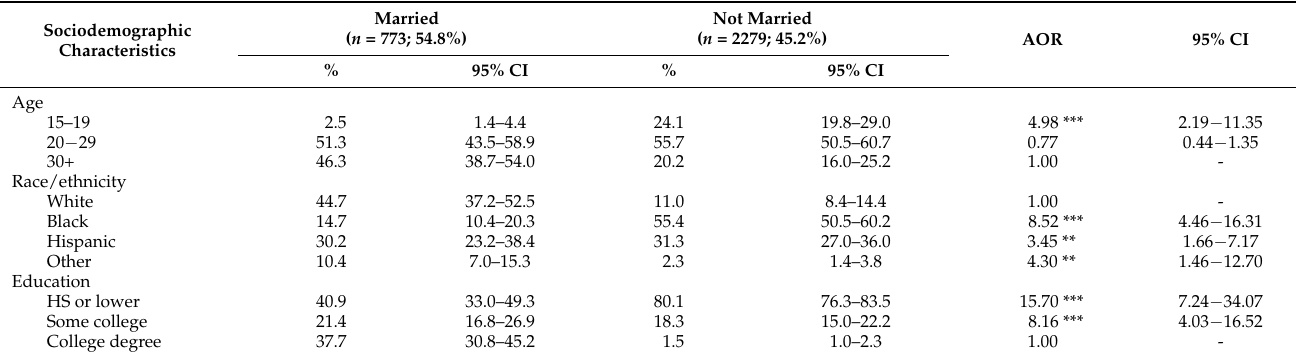
Table 1. Baseline sociodemographic characteristics among U.S. mothers by marital status at childbirth in 1999 − 2001, Fragile Families and Child Wellbeing Study ( n =